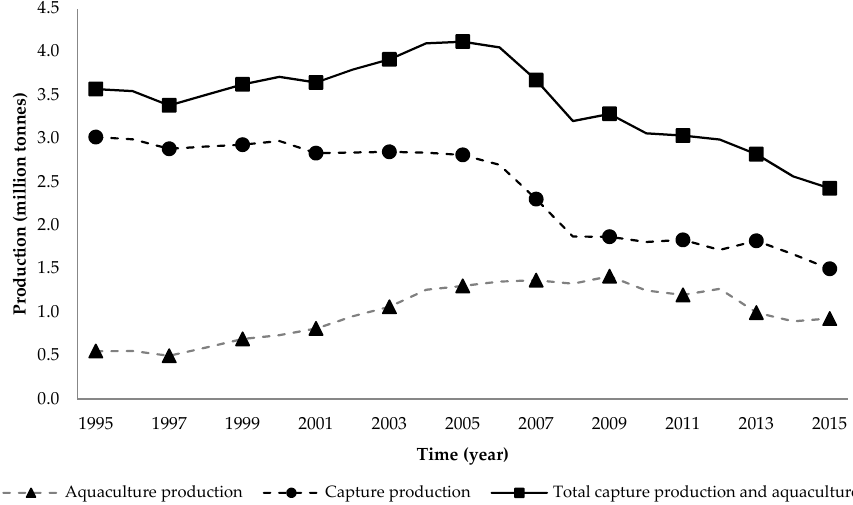
Figure 1. The yield of capture and aquaculture from 1995 to 2015. Based on data from the Department of Fisheries (DoF) [21].